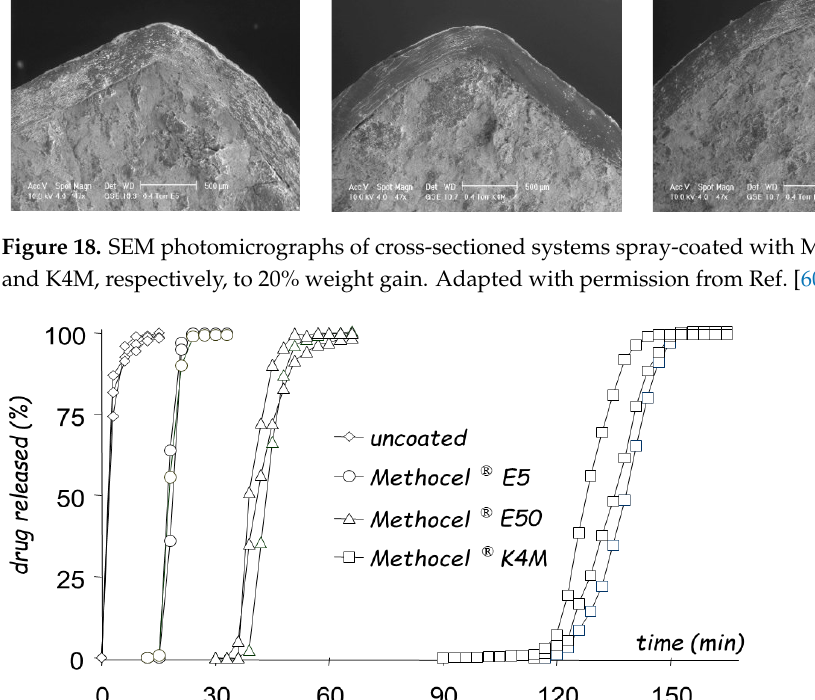
Figure 19. Paracetamol release profiles from uncoated tablets and systems spray-coated with Methocel ® E5, E50 and K4M to 20% weight gain. Reprinted with permission from Ref. [60]. 2004, Elsevier.